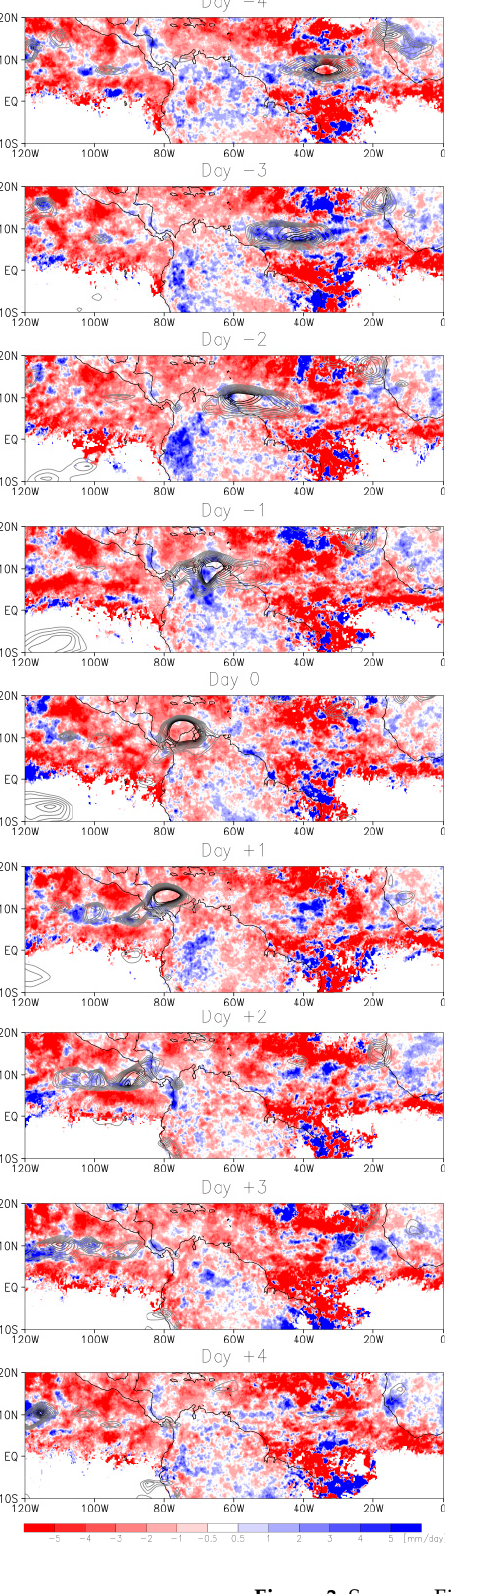
Figure 3. Same as Figure 2 but for dry